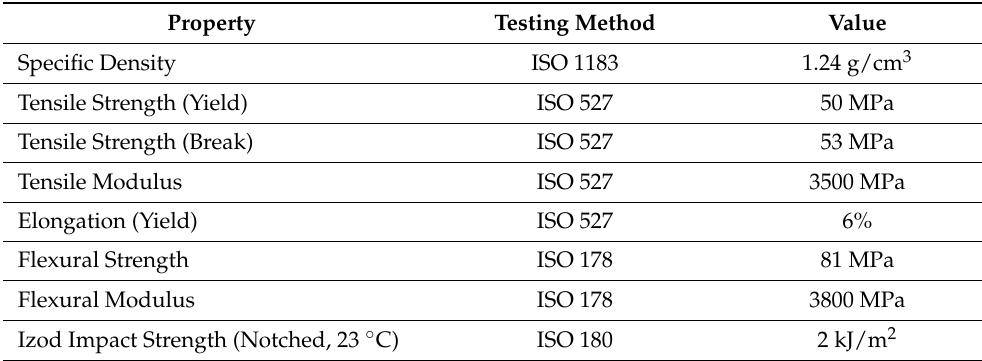
Table 1. Properties of tested materials (based on